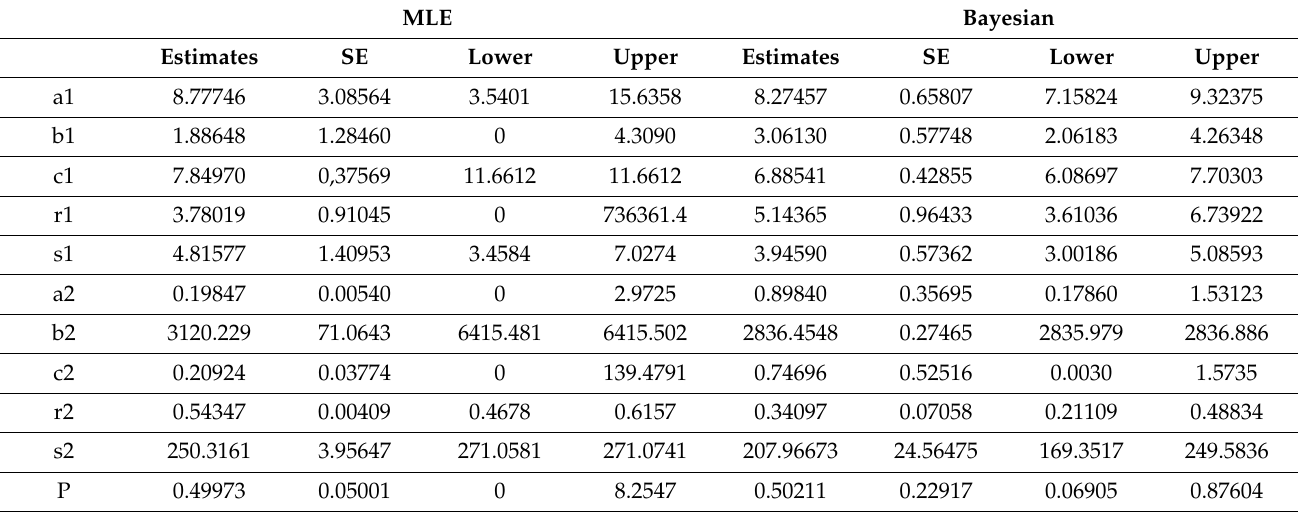
Table 7. MLE and the Bayesian estimates for the fitted MEKGEKF